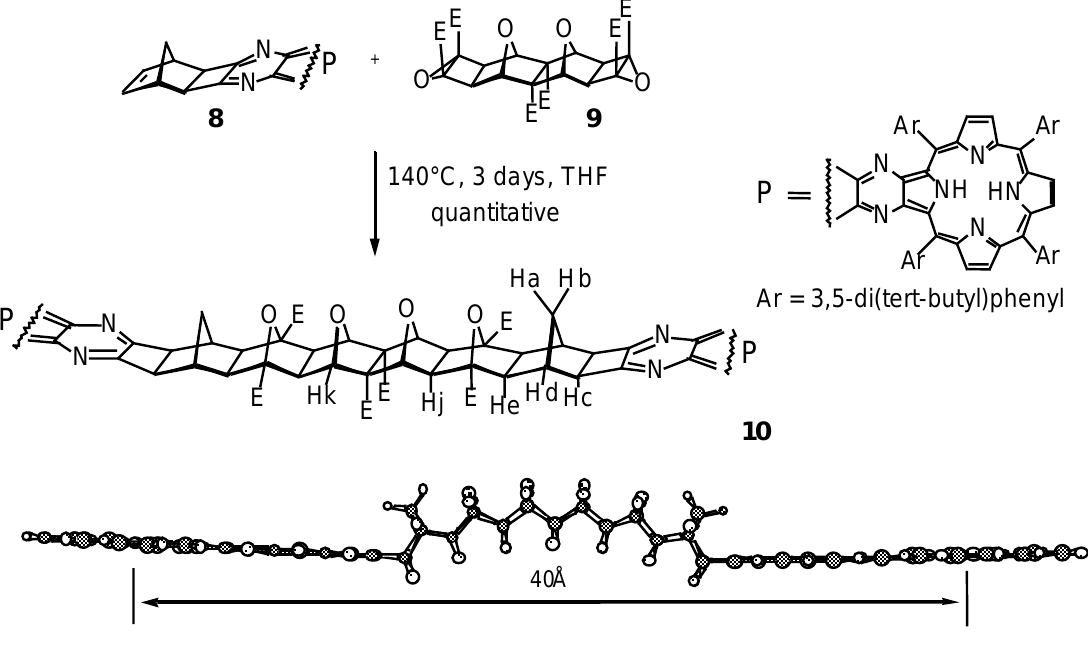
Figure 3: 1 H NMR spectrum (300 MHz, CDCl